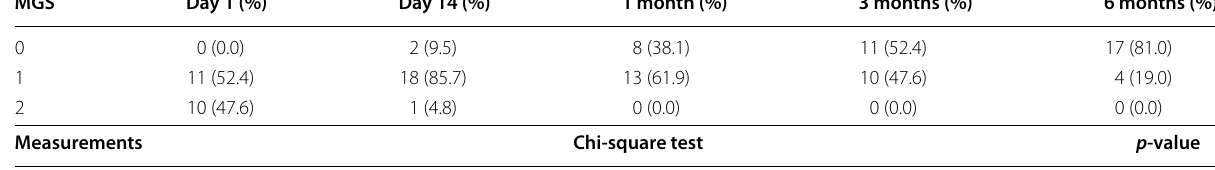
21) throughout study duration. B Comparison between